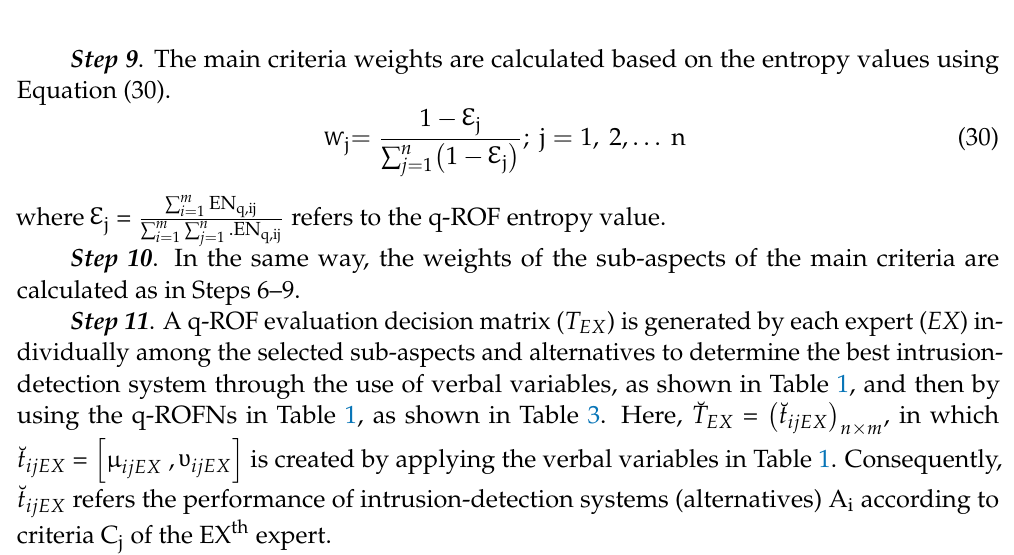
Table 3. Decision evaluation matrix for alternatives in terms of criteria based on q-ROFN. Alternatives (Intrusion-Detection Systems) Criteria